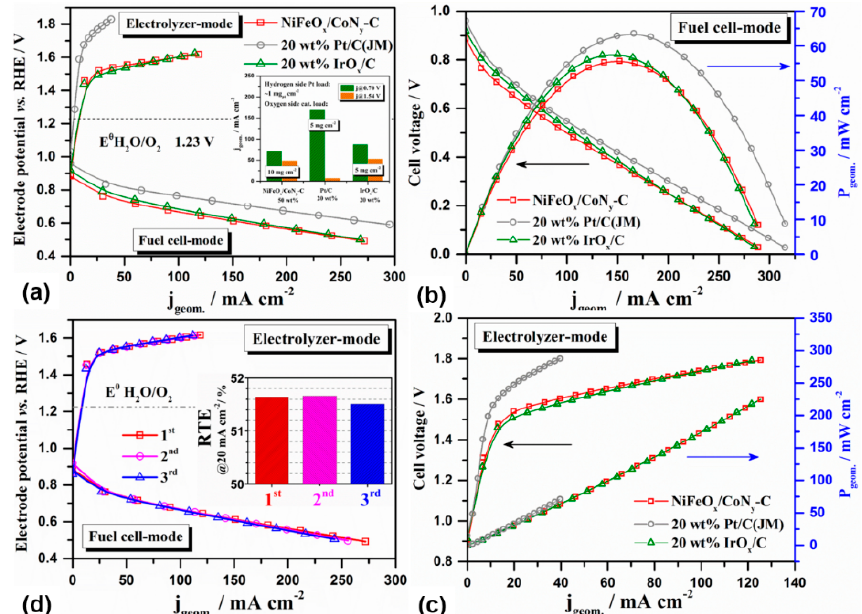
Figure 18. Alkaline laminar flow unitized regenerative micro-cell (LFURMC) experiment. ( a ) Current-potential of the material as anode (electrolyzer mode) and cathode (fuel cell mode). inset: The geometric activities comparison of three LFURMC; ( b ) the cell voltage and power density curves of the fuel cell with platinum as the hydrogen catalyst, and NiFeO x /CoN y –C, 20 wt% Pt/C and 20 wt% IrO x /C cathode catalysts; ( c ) the cell voltage and power density curves of the electrolyzer with platinum as the hydrogen catalyst, and NiFeO x /CoN y –C, 20 wt% Pt/C and 20 wt% IrO x /C cathode catalysts; ( d ) Stability tests of LFURMC based on the NiFeO x /CoN y –C catalyst (three runs),